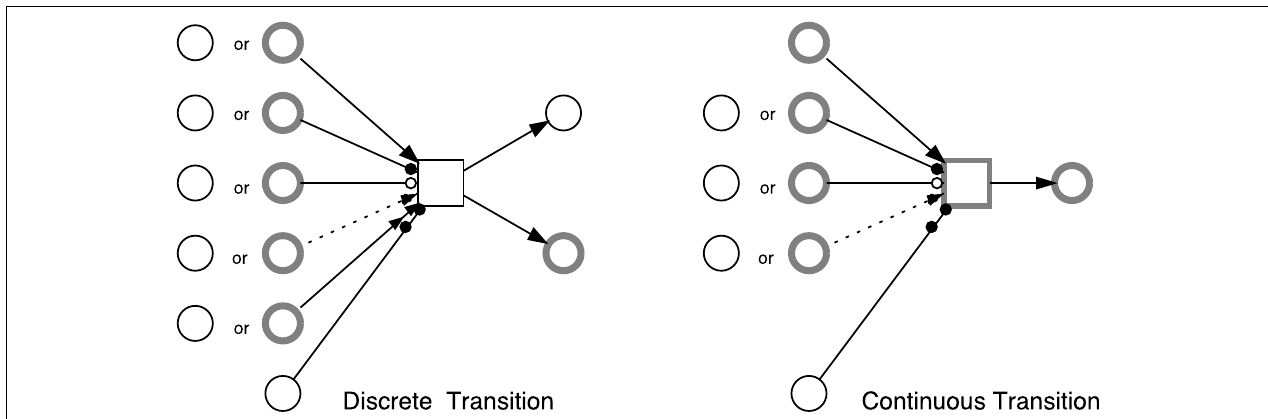
Frontiers in Environmental Science |